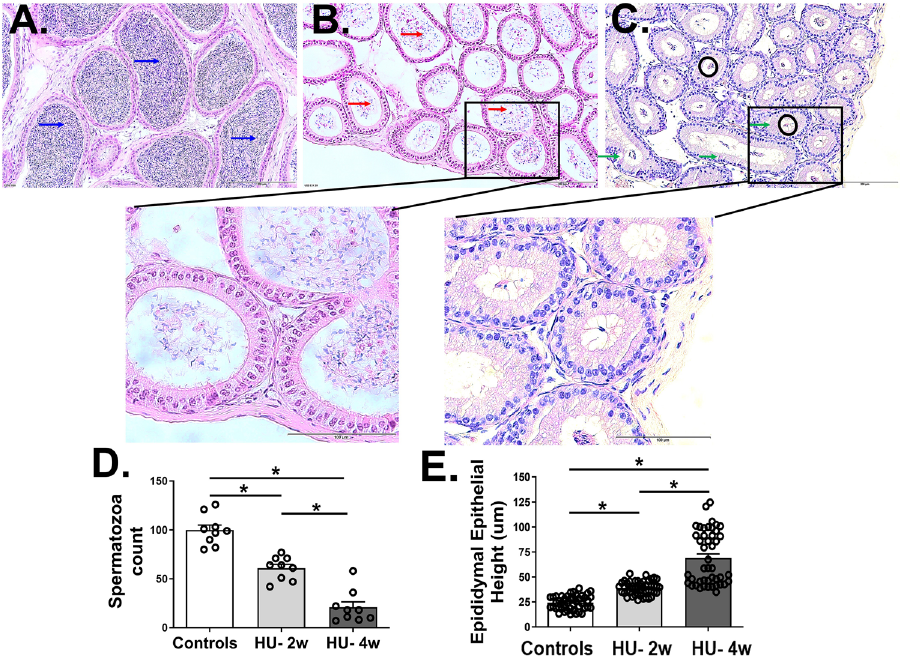
Figure 3. Histopathological features of epididymal tissues from ground-based controls ( A ) and HU mice suspended for two ( B ) and four ( C ) weeks. The image analysis shows the spermatozoa count ( D ) and epididymal epithelial height ( E ) in the three groups of mice. The high spermatozoa density (blue arrows), spermatozoa thinning and tubular debris (red arrows), retraction of the spermatozoa into the central portions of the tubular lumen (black circle), and the areas of vacuolation (green arrows) are marked in the images. Data is represented as mean ± SEM (n = 9 images/group for ( D ) and 45 images/group for ( E ), 8–12 mice/group). Images ( A – C ) were taken at 20 × magnification, while zoomed-in inset images were taken at 40 × magnification. One-way analysis of variance, *p <